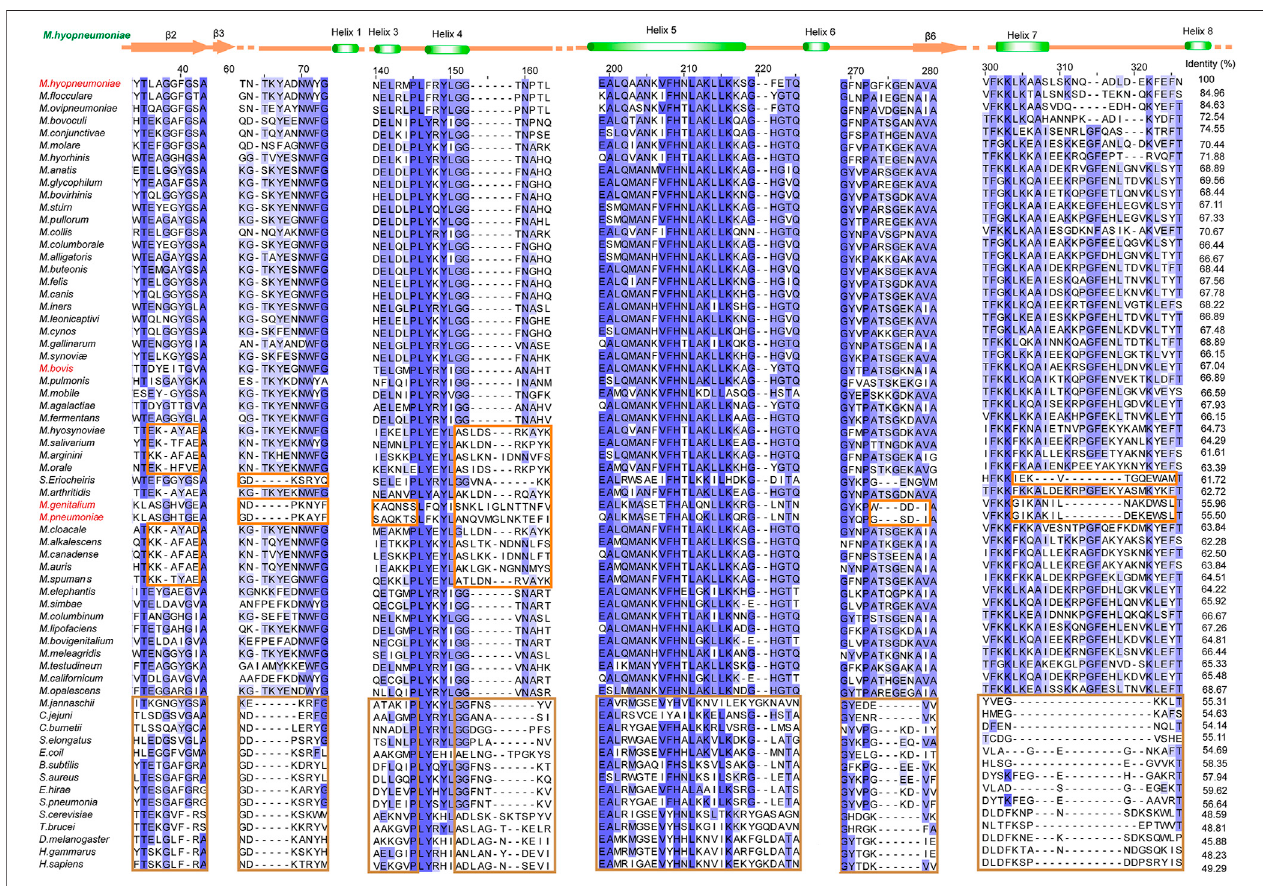
FIGURE 2 | Different sequence patterns among different enolases. Partial sequence alignment of enolases from different species. The full sequence identities are shown at the end of each sequence. The secondary structure of Mhp Eno is shown above the alignment. Different sequence patterns are highlighted with orange and brown rectangles for Mollicutes and non-Mollicutes, respectively. For sequence accession numbers, please refer to supplementary